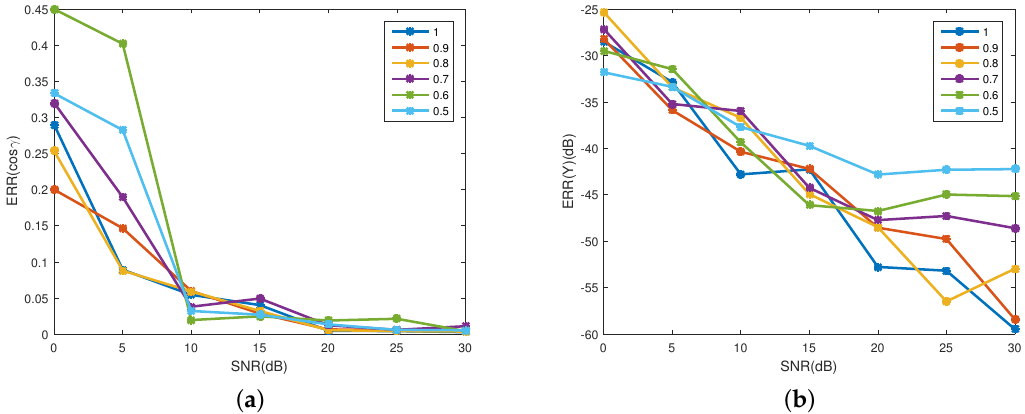
Figure 13. Estimating error of the projecting feature at different emissivity. ( a ) shows the estimating error of the observing angles; and ( b ) depicts the estimating error of the corresponding emissivity-area products. Different colors represent different emissivity, which ranges from 0.5 to 1 with a step of